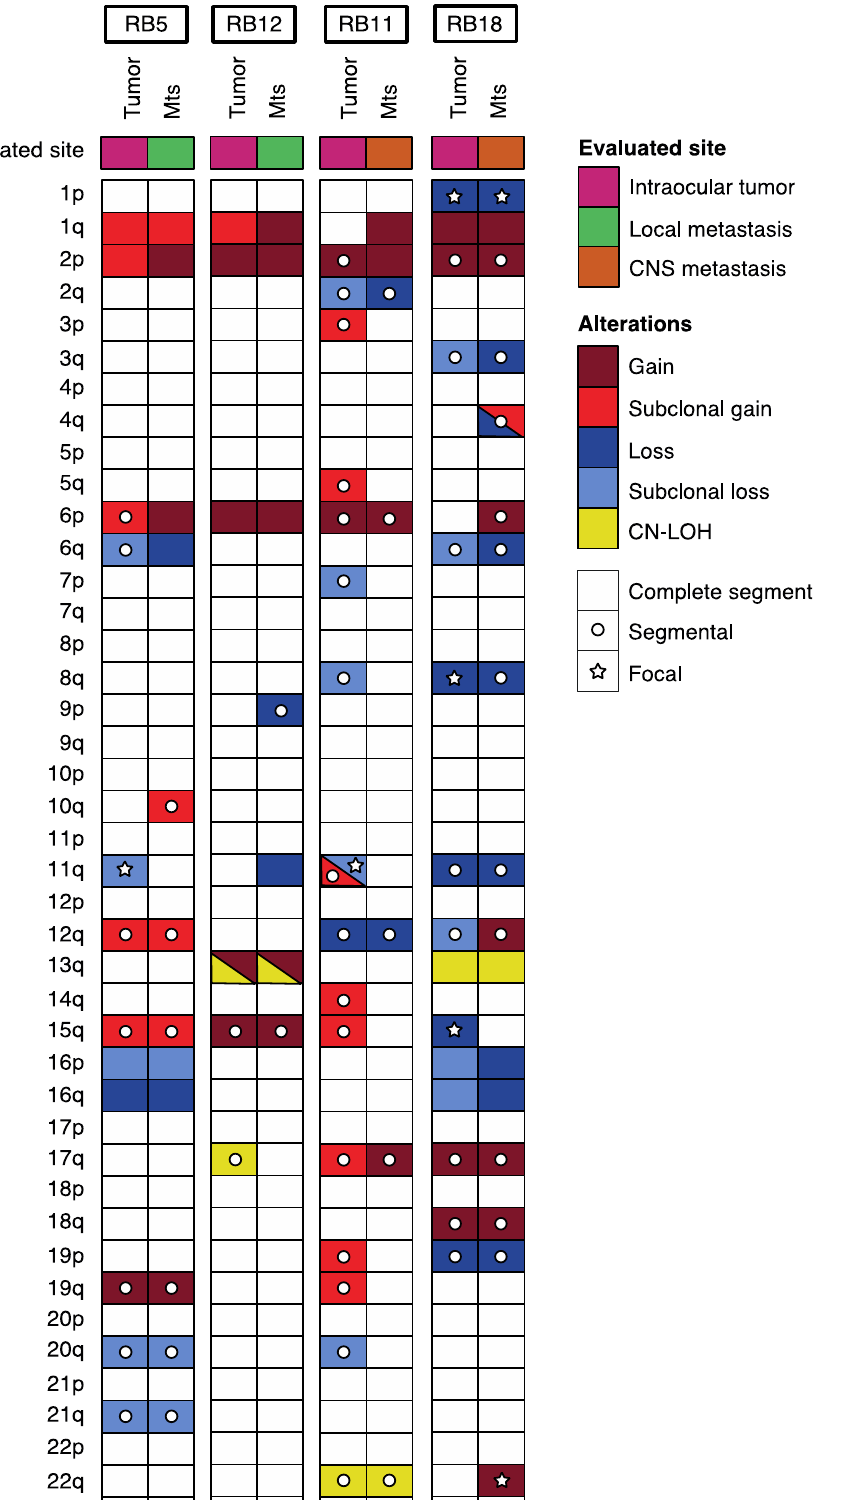
Figure 3. Landscape of somatic alterations in paired primary tumor metastatic site samples from retinoblastoma patients.